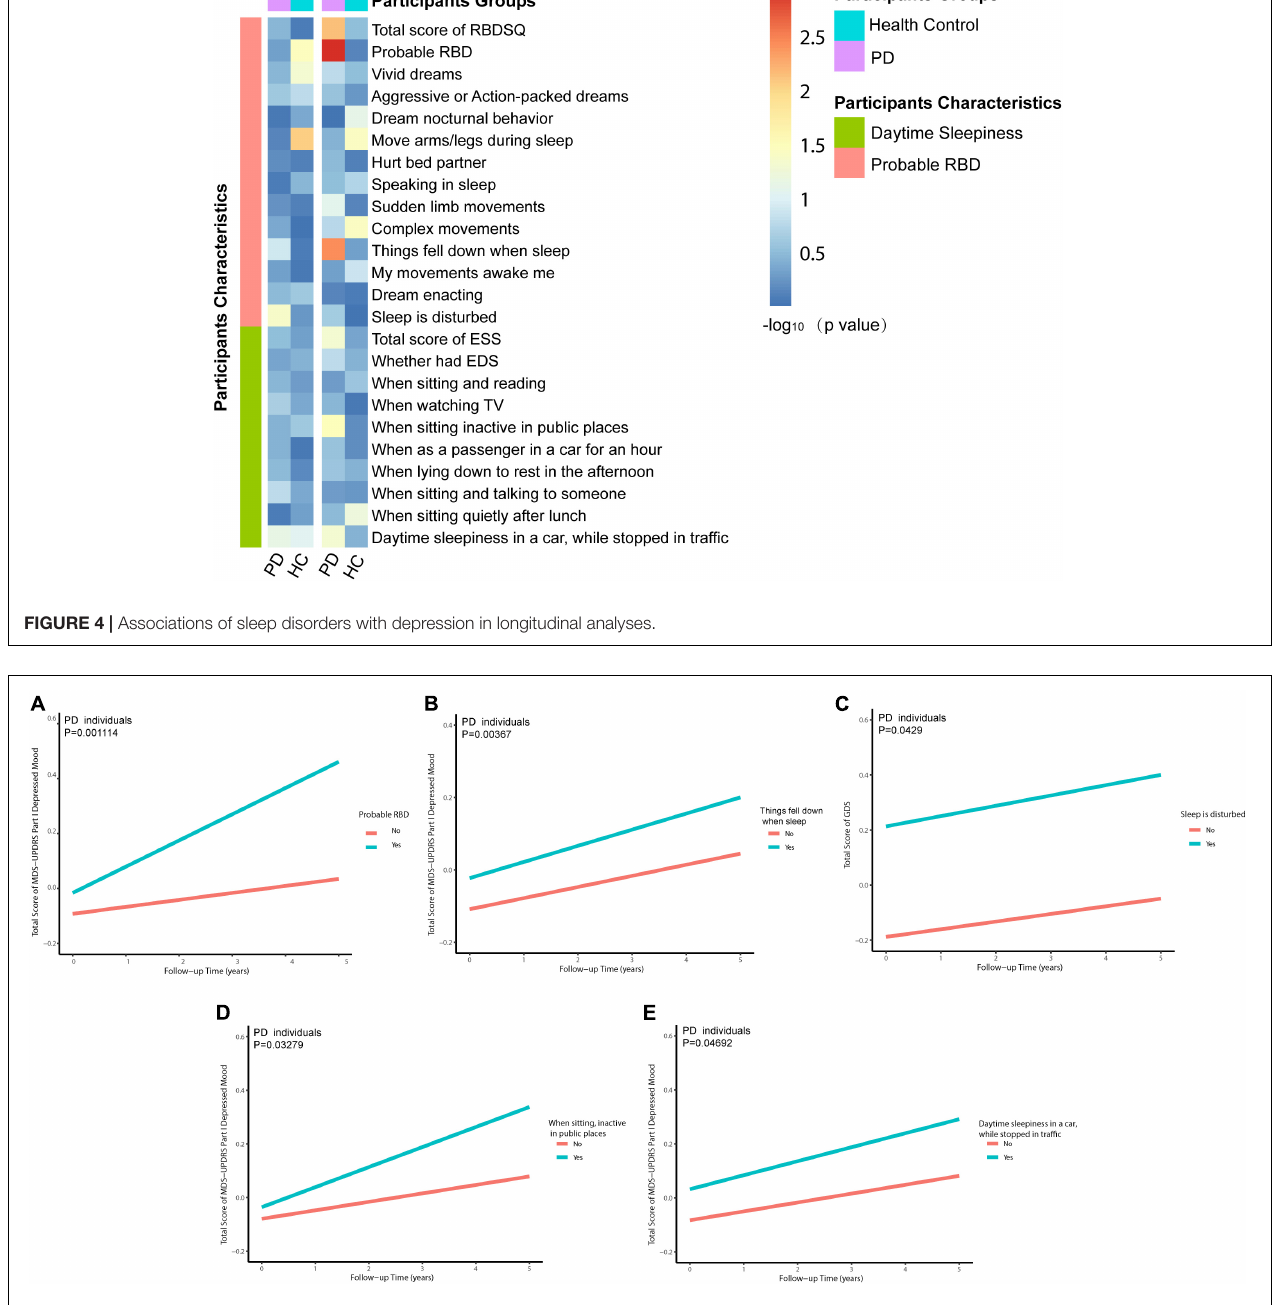
FIGURE 5 | Individuals with PD with pRBD (A) , things falling down when sleep (B) , disturbance of sleep (C) , daytime sleepiness when sitting inactive in public places (D) , and daytime sleepiness in a car, while stopped in traffic (E) contribute to a higher score of depression-related scales in PD in longitudinal analyses.